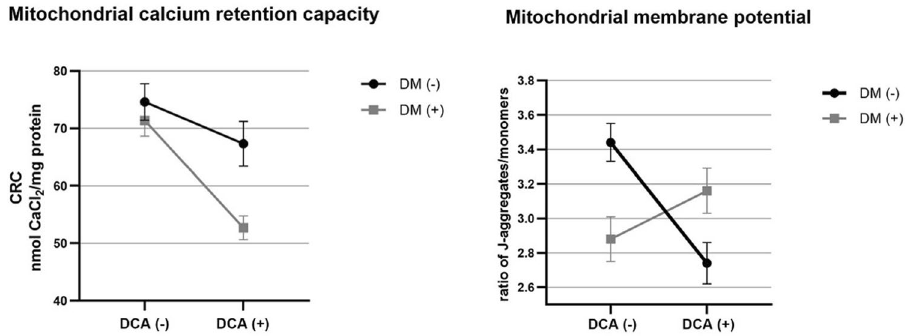
Figure 4. Graphs of the statistical interaction effect between the DCA treatment as the first main factor and experimentally induced diabetic (DM) condition as the second main factor. Both factors had two levels: exposed to DCA (DCA ( +)) or not exposed to DCA (DCA ( −)), and presence of diabetes (coded DM ( +)) or absence of diabetes (DM ( −)). Combinations of these 2 × 2 levels define all four treatment groups (the design is termed a full factorial design in two levels): “DCA ( −) and DM ( −)“ stands for healthy control group (Control); “DCA ( −) and DM ( +)“ stands for diabetic group (DM); “DCA ( +) and DM ( −)“ stands for healthy dichloroacetate group (DCA); and “DCA ( +) and DM ( +)“ stands for diabetic-dichloroacetate group (DM +